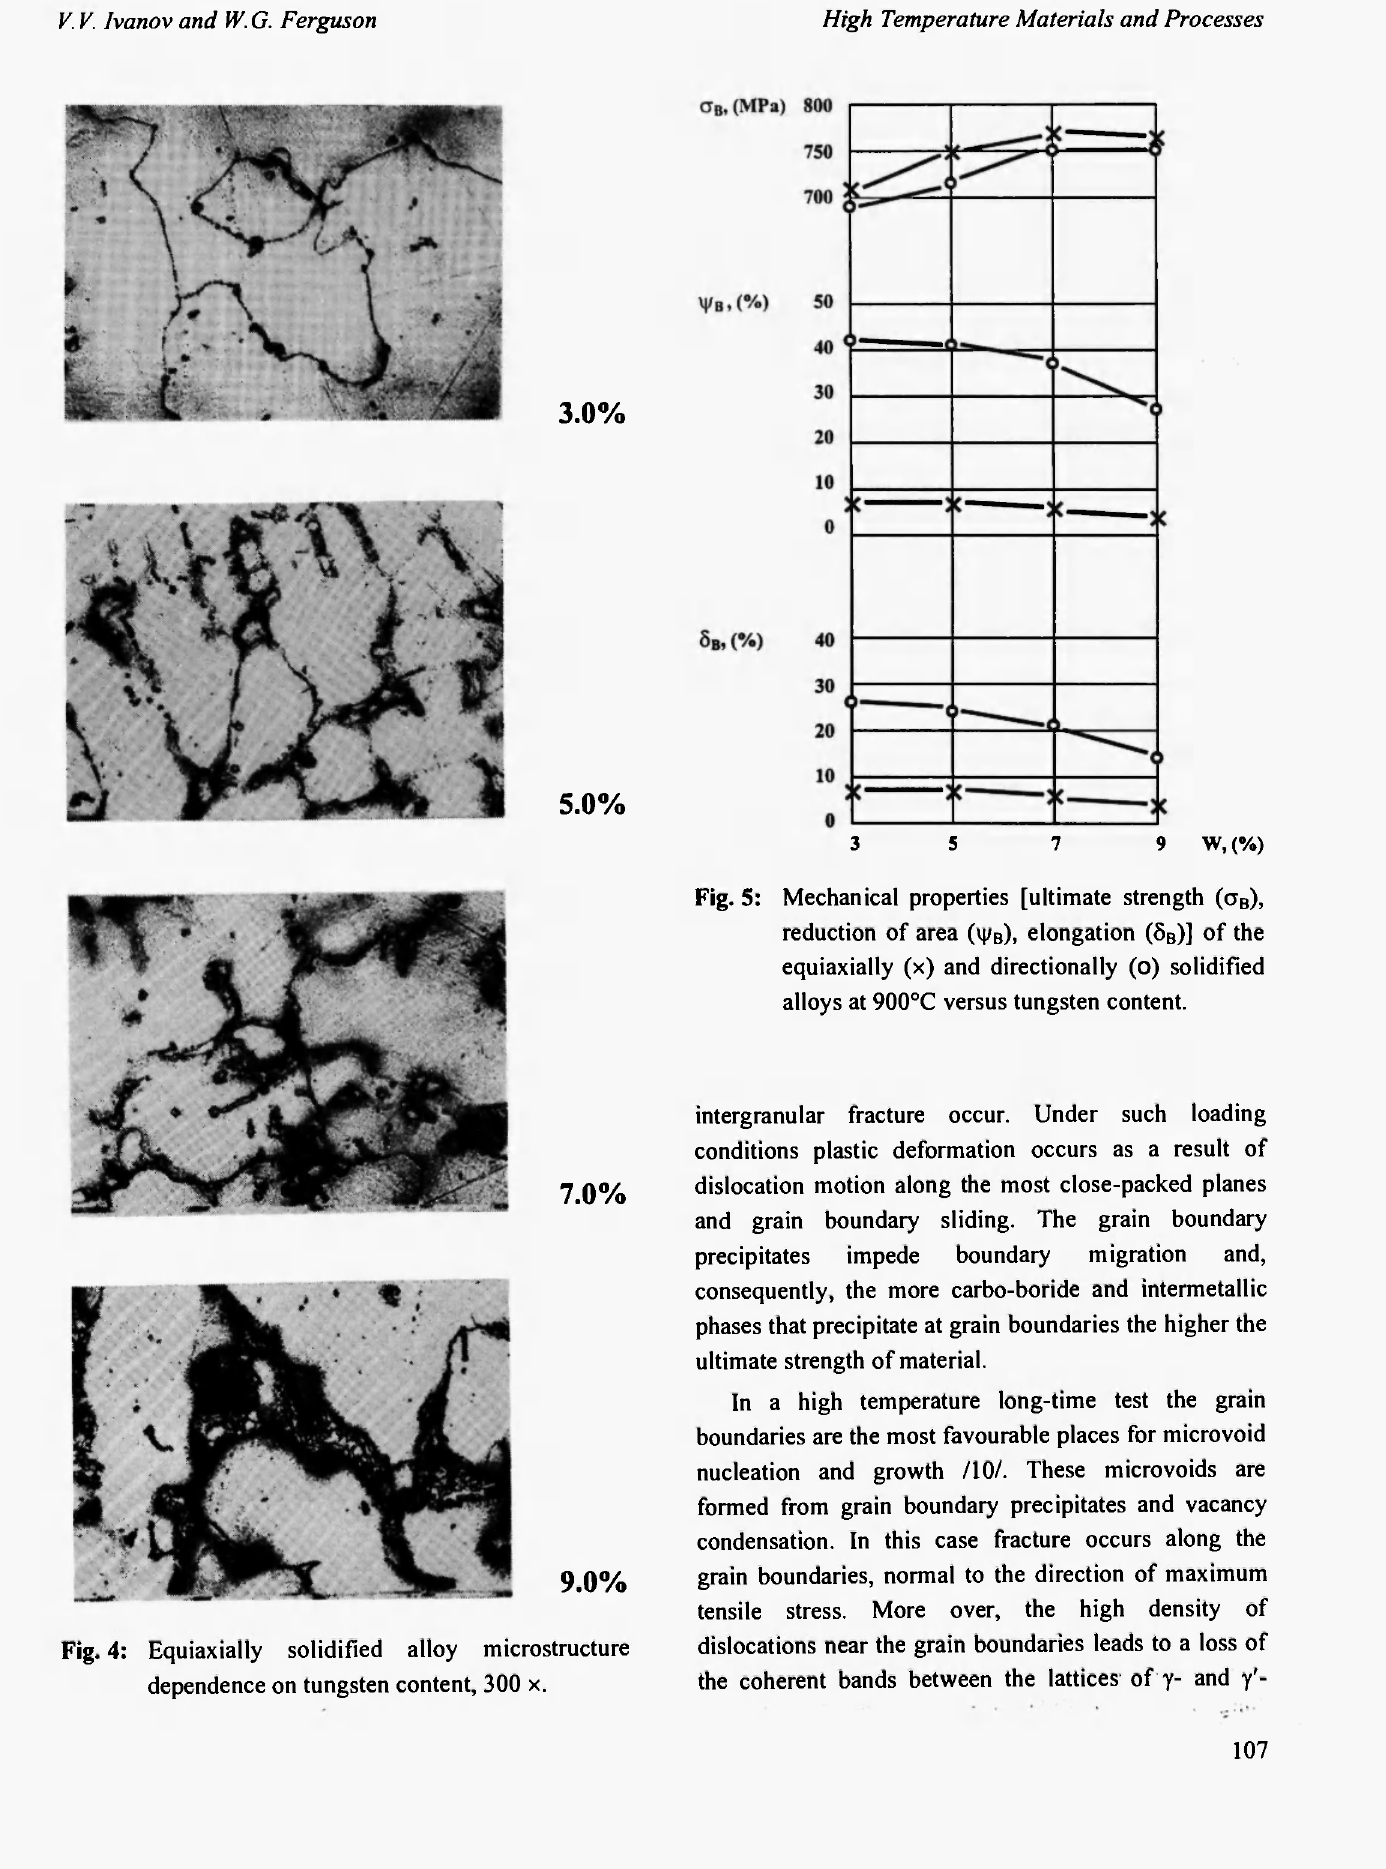
Fig. 4: Equiaxially solidified alloy microstructure dependence on tungsten content, 300 χ.